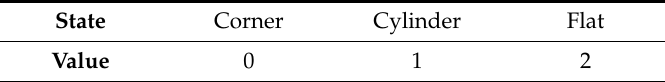
Table 3. Language conversion of feature types